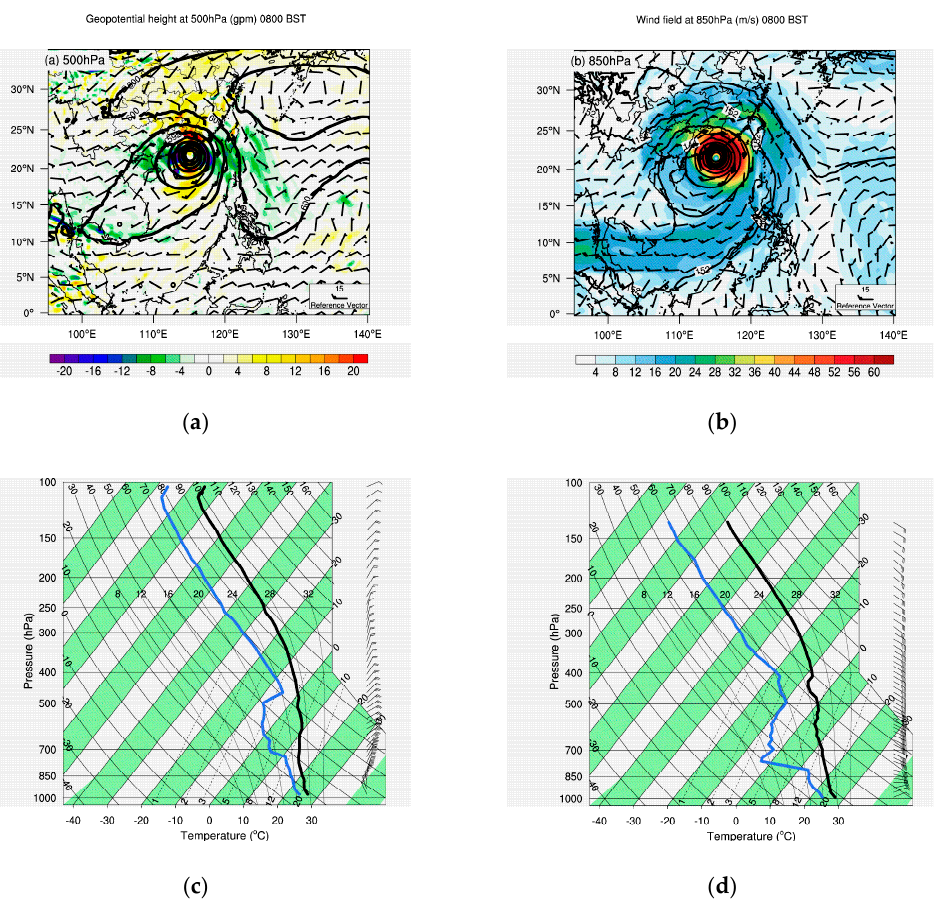
Figure 2. National Centers for Environmental Prediction reanalysis data with a 0.25° × 0.25° spatial resolution collected at 08:00 BST on September 16, 2018. ( a ) Vorticity field (10 –5 s –1 ) at 500 hPa, and ( b ) wind field and moisture flux divergence (g cm –1 hPa –1 s –1 ) at 850 hPa. T–lnp curves for 06:00 BST on 16 September 2018 at ( c ) Yangjiang station and ( d ) Heyuan station.